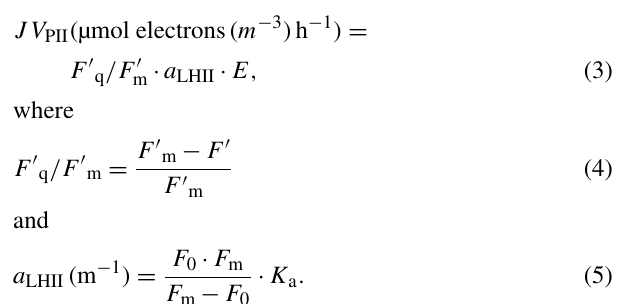
Parameters calculated from parameters derived from fluorescence light curve and irradiance Surface GPP Surface gross primary productivity (see Eq. 3) calculated based on the